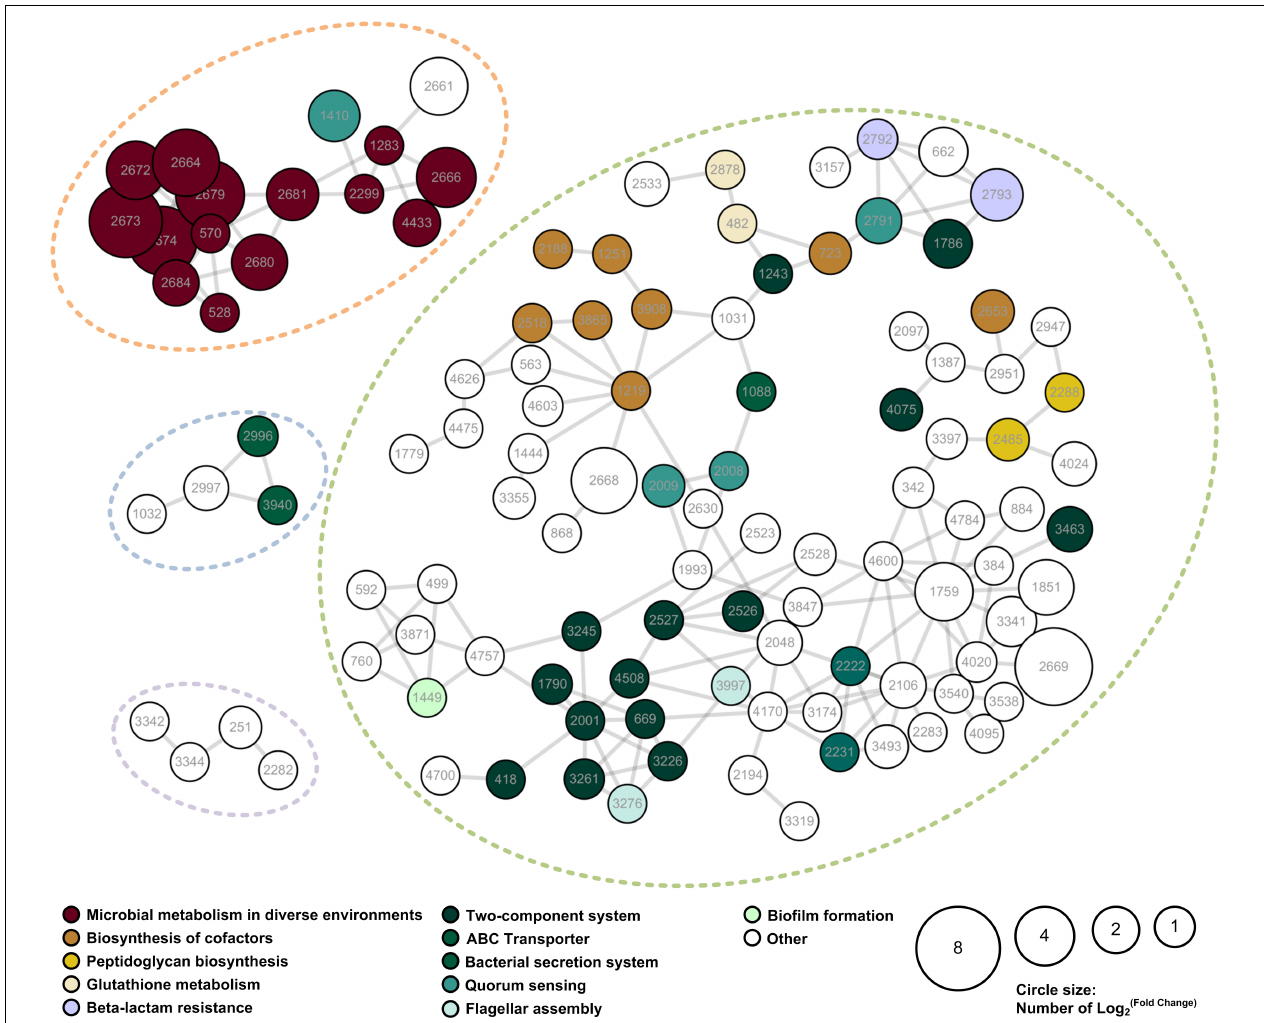
FIGURE 5 | PPI network of the IAA-up DAPs were searched for their PPI using the web resource STRING and characterized using Cytoscape. Networks with at least 3 elements are shown in the figure. The size of the circle denoted the fold-change of the protein. Fold-change of the DAPs that were unique to the IAA group was set as 2. The enriched KEGG functions of the DAPs are indicated in different